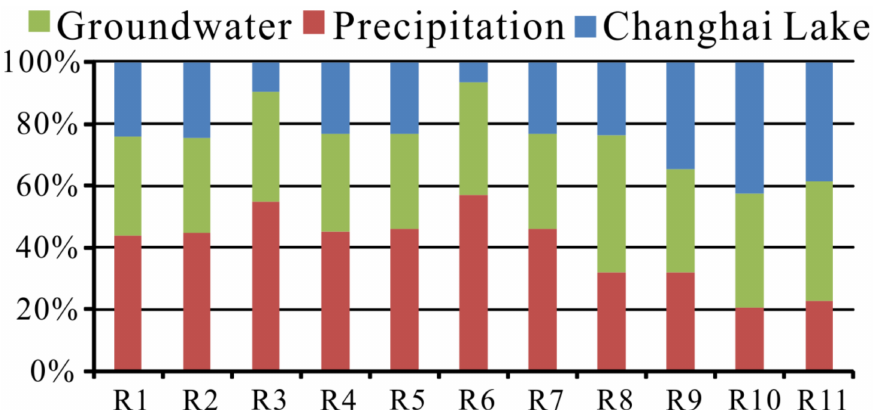
Figure 11. Estimated fraction of water sources as a result of hydrograph separation along the RZ